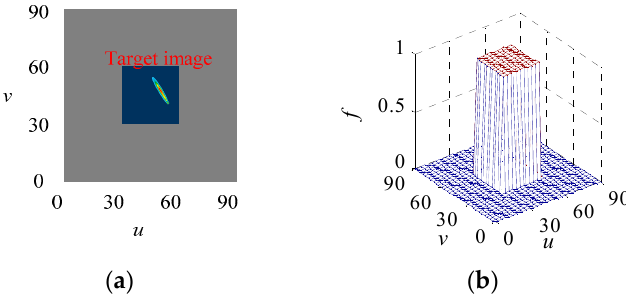
Figure 3. Likelihood probability density distribution. ( a ) is target image on focal plane, ( b ) is likelihood probability density distribution.